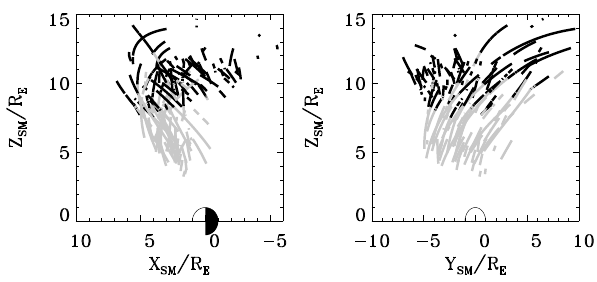
Fig. 1. Cusp crossings observed by Magion-4 during 1995–1997 years plotted in SM coordinates. Different colours distinguish mea- surements made closer or farther than 3 R E from the magnetopause (T96